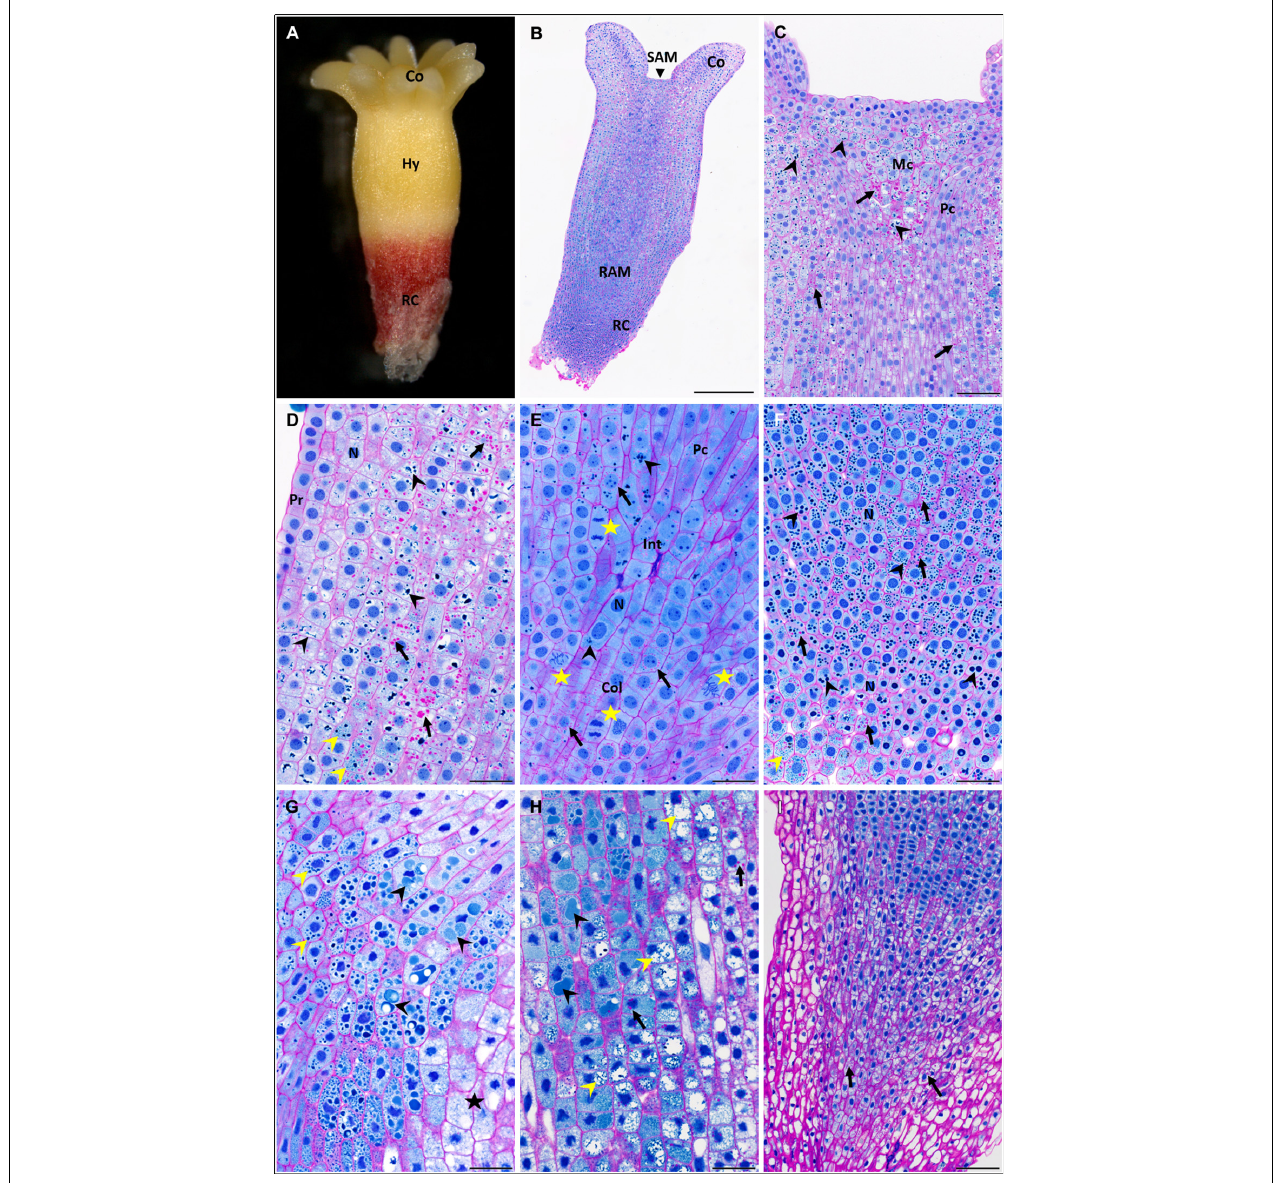
FIGURE 2 | Accumulation of storage compounds in somatic embryos (SEs) of P. abies after two and three weeks of desiccation. (A–F) Two weeks of desiccation (D2); (G–I) three weeks of desiccation (D3). (A) Morphology of a D2 embryo; note the red coloring of the root cap that was induced during desiccation in light. (B) Longitudinal section of a D2 embryo stained with PAS/amido black [polysaccharides in cell walls and starch grains stained magenta, proteins in nuclei and protein storage vacuoles (PSVs) stained blue]. (C) Detail of the shoot apex in panel (B) ; starch grains (arrows) accumulated frequently in the region of central mother cells of the shoot meristem and in cortical cells but less in cells of the procambium; PSVs (arrowheads) were located similarly. (D) Detail of the hypocotyl cortex in panel (B) ; starch grains occurred predominantly in deeper cortical cells than in sub-protodermal cells (arrows); individual PSVs occurred in the cytoplasm, but more often PSVs clustered and/or fused in vacuoles (black arrowheads); very tiny PSVs occurred in some cells (yellow arrowhead). (E) Detail of the root apical meristem in panel (B) ; starch grains (arrows) often surrounded nuclei; PSVs were rare (arrowheads); note the frequent mitotic figures (stars) next to root initials and in the columella. (F) Detail of the root cap in panel (B) ; starch grains were present in most root cap cells (arrows), but PSVs of different sizes predominated (black arrowheads); very tiny PSVs occurred in the distal region of the embryo (yellow arrowhead). (G) Detail of the hypocotyl cortex below the cotyledons of a D3 embryo; starch grains were very rare; intact individual PSVs were observed (yellow arrowheads) in cells located in the central pith of the embryo contrary to cells of the sub-protodermal region (star); in the cells in between, proteinaceous content occurred in large vacuoles as an amorphous material (black arrowheads). (H) Detail of the basal part of the hypocotyl cortex of a D3 embryo; starch grains were more abundant than below the cotyledons (arrows); individual PSVs disappeared, while the proteinaceous content occurred in large vacuoles as an amorphous (black arrowheads) or dispersed material (yellow arrowheads). (I) Root cap of a D3 embryo was free of PSVs, starch grains occurred only in the central part (arrows). Co, cotyledons; Col, columella; Hy, hypocotyl; Int, root initials; Mc, mother cells of the shoot meristem; N, nucleus; Pc, procambium; Pr, protoderm; RAM, root apical meristem; RC, root cap; SAM, shoot apical meristem. Scale bars represent: 500 µ m in panel (B) ; 100 µ m in panels (C,I) ; 50 µ m in panels (D–H)